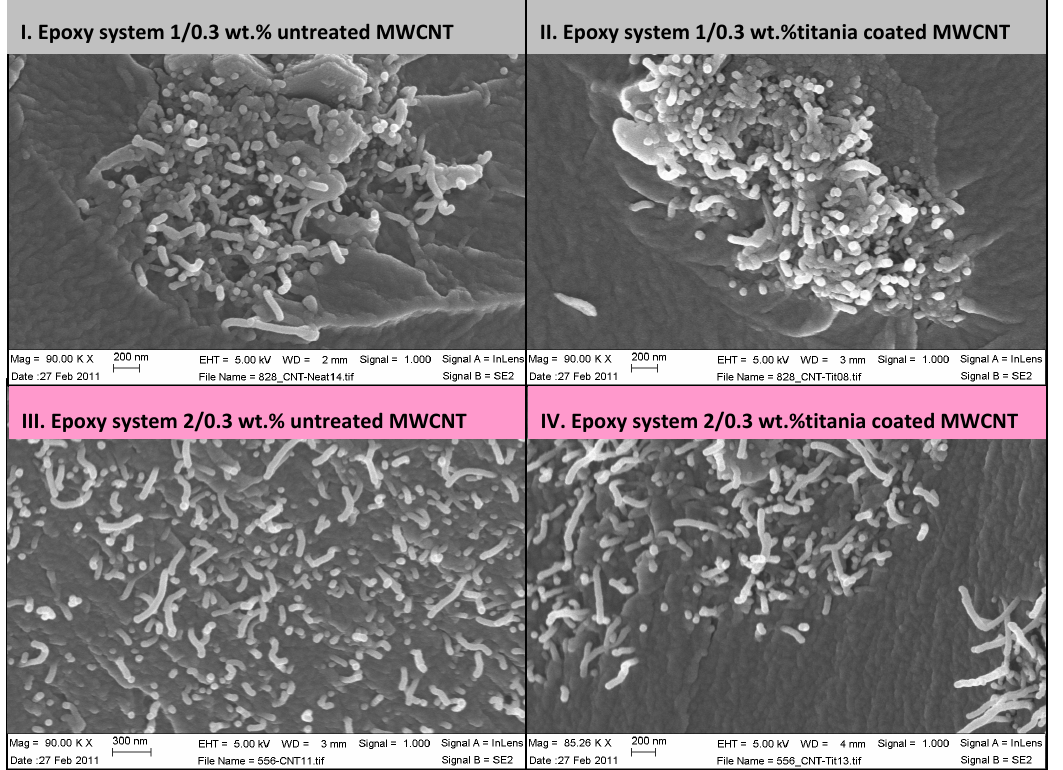
Figure 5. SEM images of titania coated and non-treated MWCNT